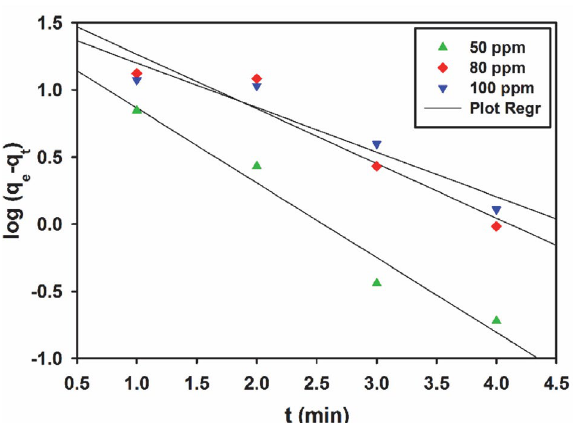
Figure 13. Results of the pseudo second-order rate rather than the first-order